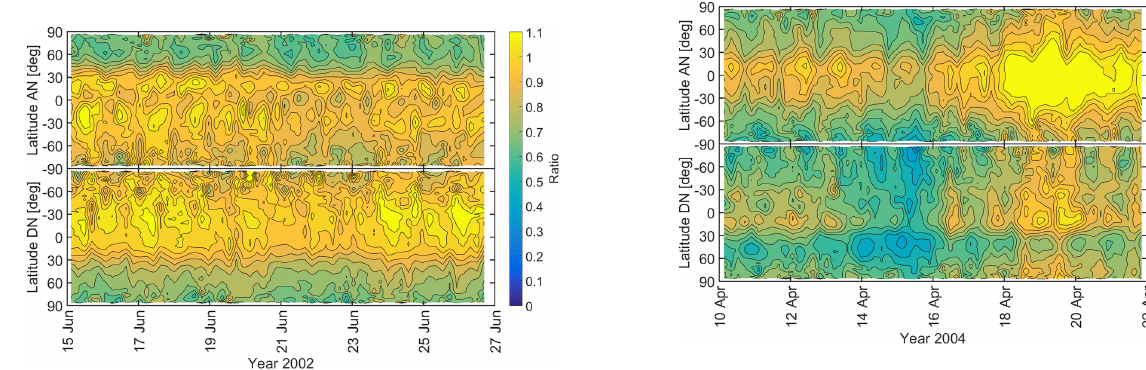
Figure 13. Density ratio (GITM / CHAMP) as a function of time and latitude for “case d” (LTAN = 10:01; LTDN = 22:01; h apogee = 410km; h perigee =